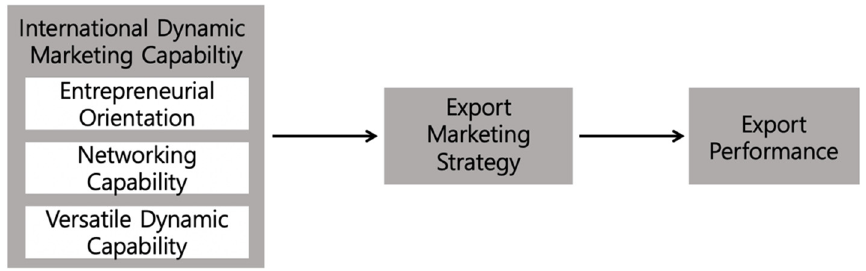
Figure 2. International dynamic marketing capabilities of emerging-market small business.